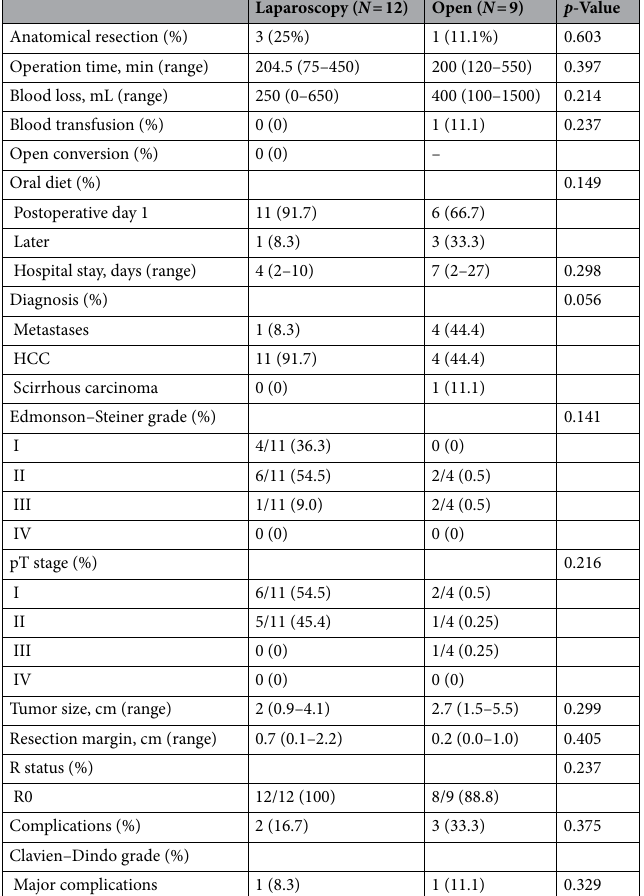
Table 2. A correct version of the original Table